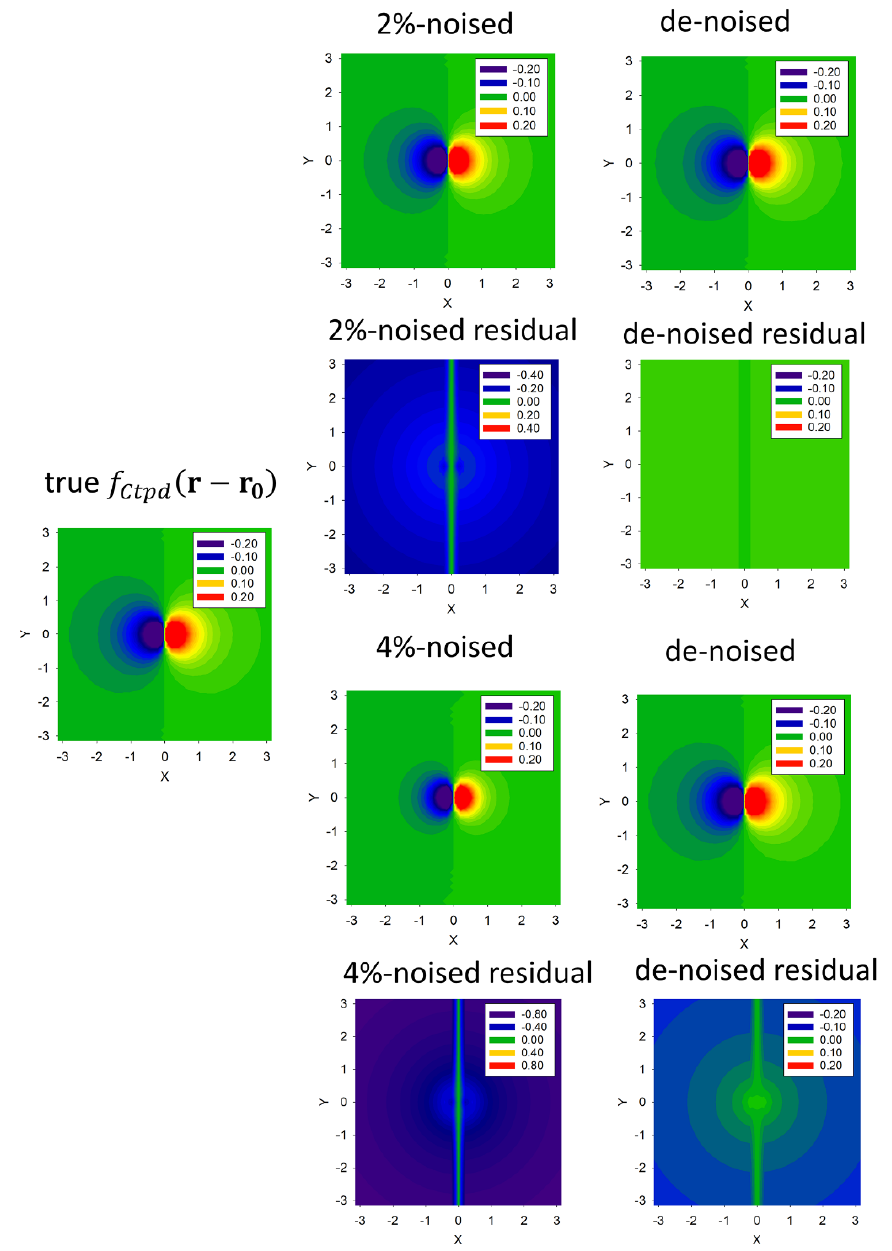
Figure 5. Cross-sections of the true function f Ctpd ( r − r 0 ) (left). Cross-sections of the function f Ctpd ( r − r 0 ) : the Poisson-noise (middle) and noise-average (right) ones. The total number of the 2D Poisson-noise IPs frames U =100. The residual cross-section functions ∆ f Ctpd ( r − r 0 ) obtained by subtraction of the true f Ctpd ( r − r 0 ) from the recovered ones are shown, as